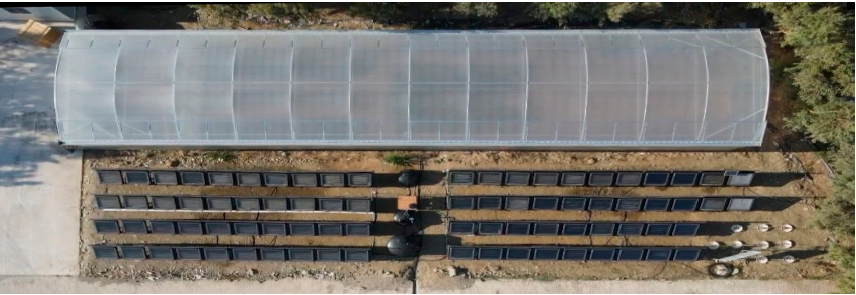
Figure 15. Solar power desalination system.